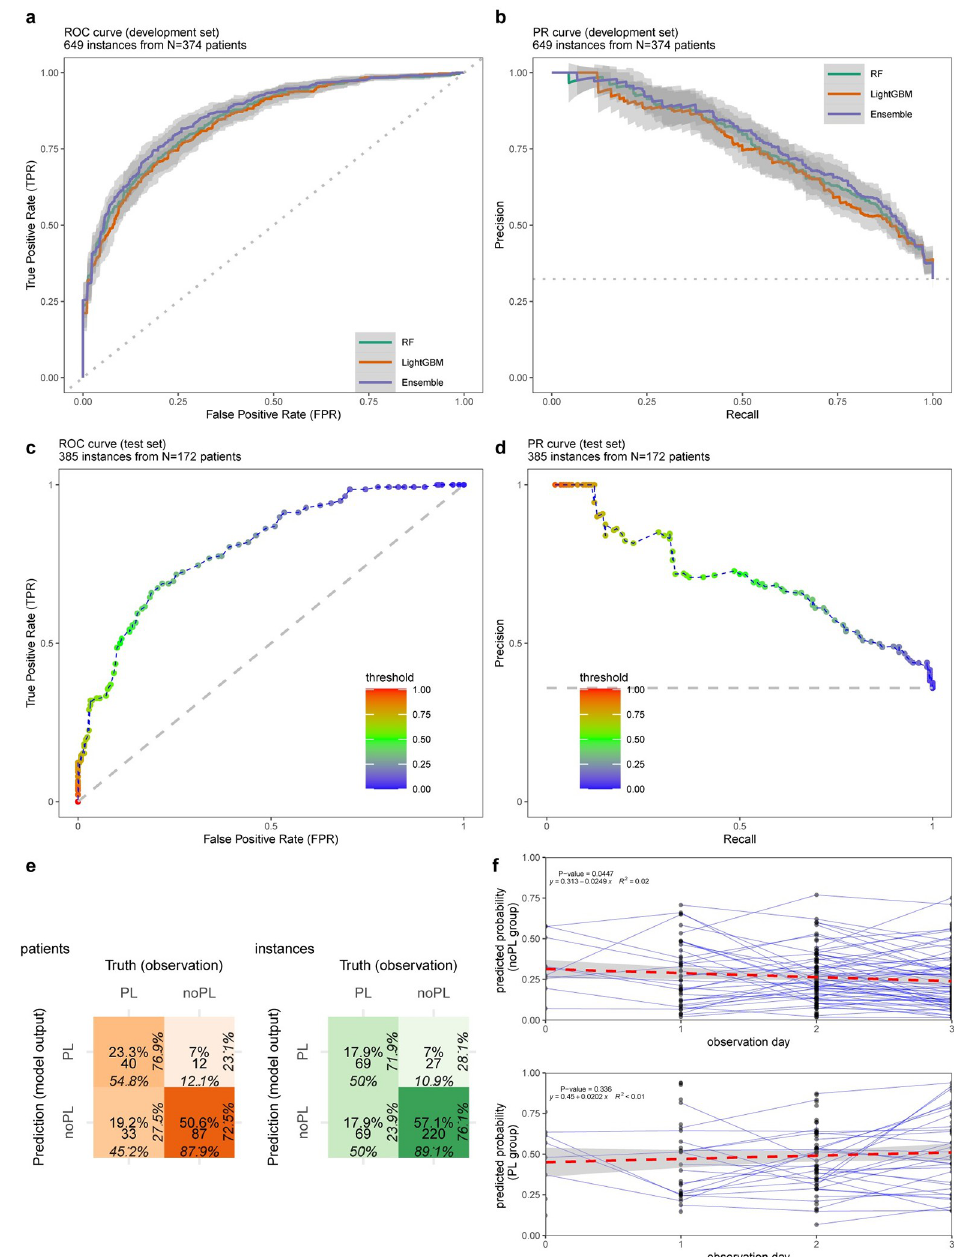
Fig 2. An overview of the machine learning results. a) ROC curve for gradient boosting machine (LightGBM), random forest (RF) and their average stacking (Ensemble) using varying prediction probability thresholds from 0 to 1 (step size = 0.01). b) PR curves for the learners using the same thresholding. c) ROC for the final model, DENV 5F-AS : 5-Featured Average Stacking of LightGBM and RF, on the test set (AUC = 0.80). d) PR curve for the final model on the test set (PRAUC = 0.69). e) Confusion matrix for DENV 5F-AS on the test set (green: all instances, orange: earliest instances of patients), percentages in each direction provide the proportion of instances of each row or column. PL: plasma leakage and noPL: no plasma leakage. The colour intensity is proportional to the ratio of the instances of a matrix cell to the total number of instances. The percentages indicate proportion of classified instances in each cell to the instances in neighbouring cells by row or column, f) Prediction probabilities during the observation period for patients in each class where each point indicate an instance and the connected points indicate that the instances belong to the same patient. The trends of the predicted probabilities for each class are shown by fitting linear regression.